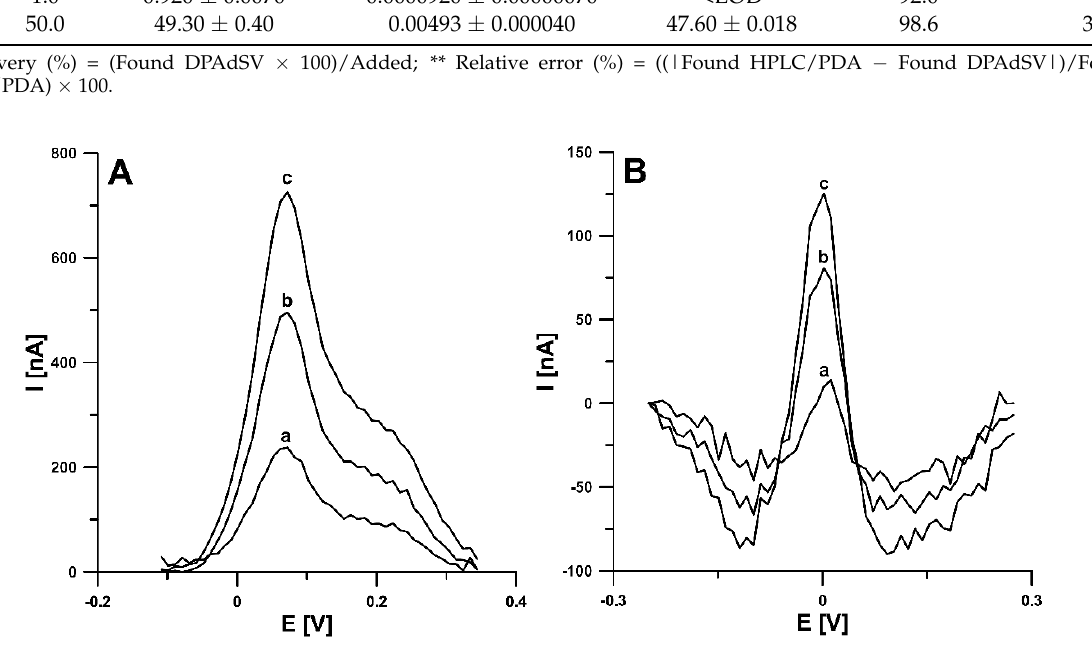
Figure 10. DPAdSV curves obtained for the determination of RIF in Bystrzyca river water sample ( A ): (a) 1 mL of sample + 0.1, (b) as (a) + 0.1, (c) as (a) + 0.2 nM RIF and bovine urine sample ( B ): 1 µL of sample + 0.1, (b) as (a) + 0.1, (c) as (a) + 0.2 nM RIF. The DPAdSV parameters: Eacc of − 0.45 V, tacc of 30 s, Δ E A of 150 mV, ν of 100 mV s − 1 and t m of 5 ms.